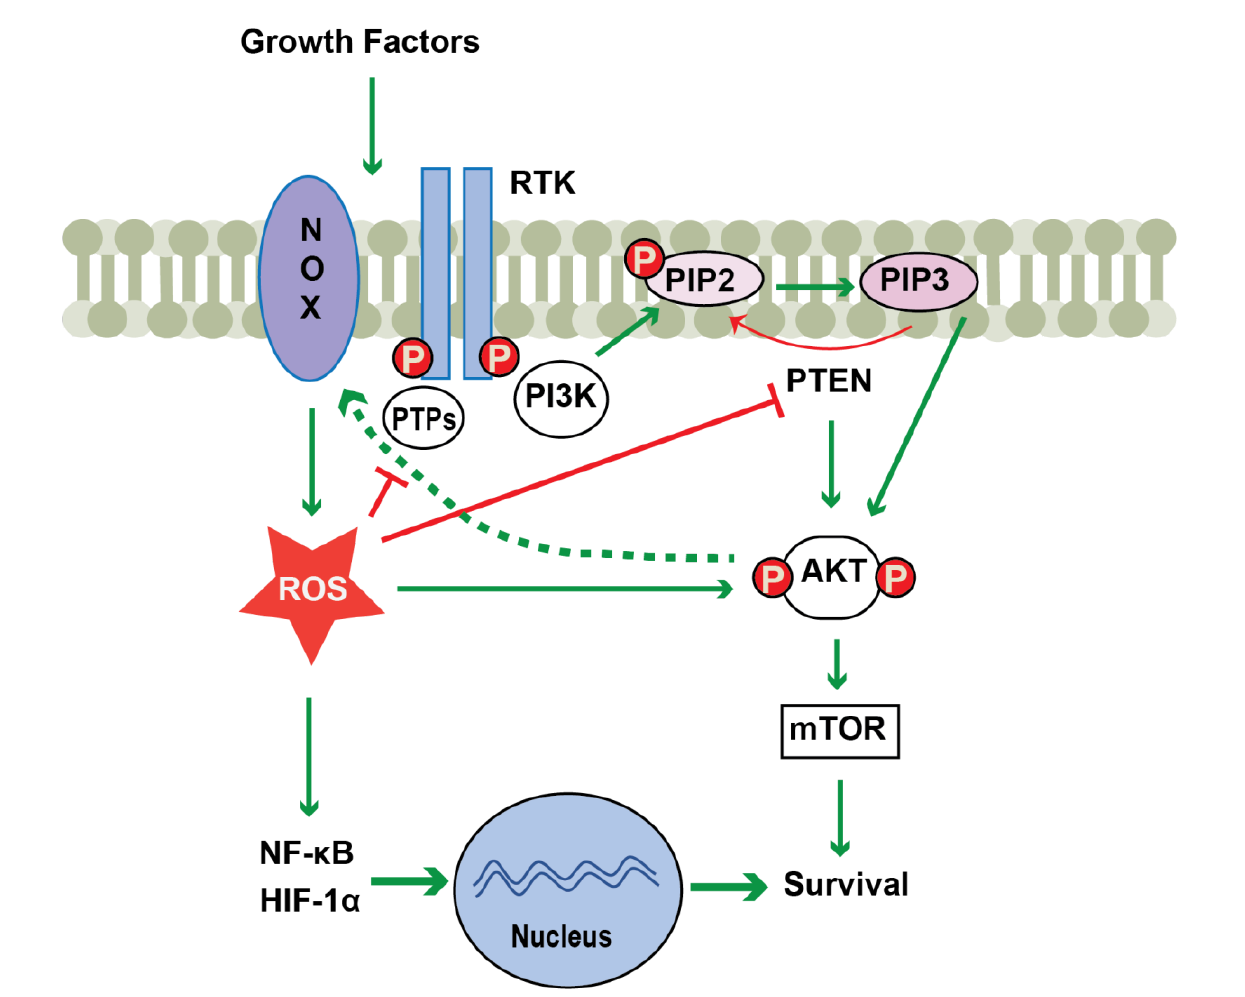
Figure 1. Schematic representation of NOX regulation of the PI3K/AKT pathway. Activation of NOX occurs upon, for example, growth factor stimulation. NOX-derived ROS potentiate the PI3K signaling cascade by directly activating AKT, or indirectly through inhibition of phosphatases such as PTEN or PTPs. In addition, NOX-derived ROS induce the nuclear translocation of NF- κ B and HIF-1 α , which promotes cell survival. ROS-mediated activation of AKT also serves to enhance NOX-derived ROS production in a positive feedback loop (dashed green arrow). Abbreviations: RTKs, receptor tyrosine kinases; PI3K, phosphoinositide 3-kinase; PIP2, phosphatidylinositol-4,5-bisphosphate; PIP3, phosphatidylinositol-3,4,5-trisphosphate; AKT, protein kinase B; PTP, protein tyrosine phosphatase; PTEN, phosphatase and tensin homolog; Green arrows and green dotted arrow indicate activation and red block arrows indicate inhibition; P, phosphorylation.